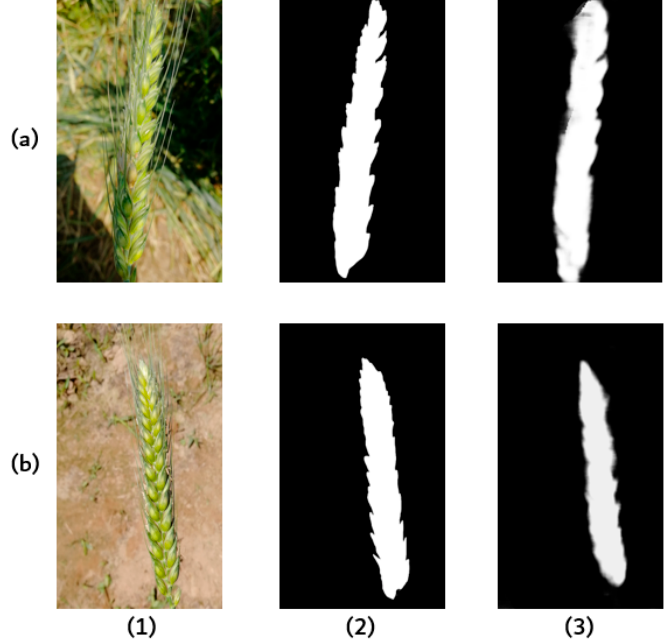
Figure 12. Segmentation results of single wheat ear under different effect factors. ( a1 , b1 ) mean the effects of shadow and soil on the single wheat ear. ( a2 , b2 ), ( a3 , b3 ) represent the ground truth and model segmentation results, respectively.